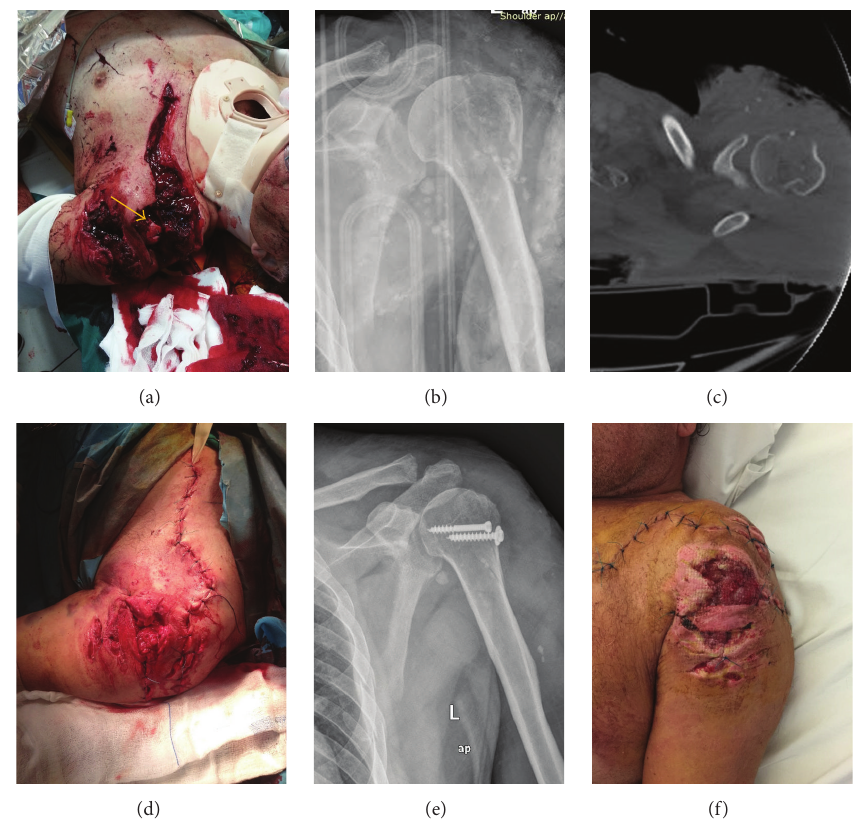
Figure1:(a)Photographyofthetraumaduringpatientresuscitationindicatedsevere,sword-likeinjurytotheleftshoulder,withopenfracture of the humeral head (arrow). (b) Preoperative anteroposterior X-ray of the left shoulder showing head-splitting fracture of the proximal humerus and presence of multiple foreign bodies (glass). (c) CT scan of the left shoulder indicating involvement of ∼ 30% of the articular surface and the greater tuberosity. (d) Intraoperative picture after muscle and skin closure. (e) Postoperative X-ray of the left shoulder showing adequate reduction of the fragment. (f) Condition of the skin at the 10th postoperative day just before a split skin graft was about to